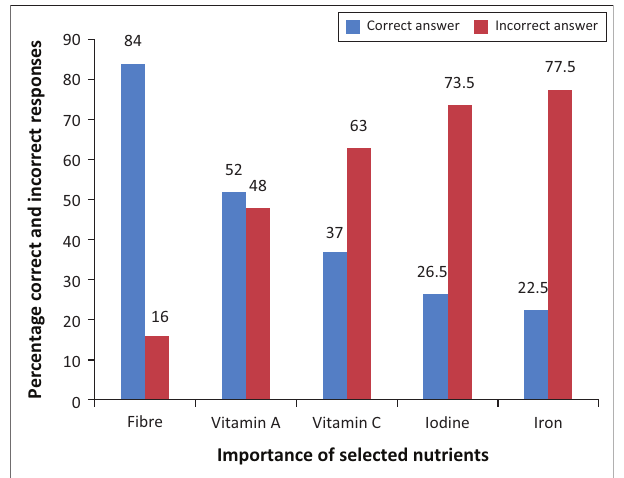
FIGURE 5: Importance of selected nutrients .